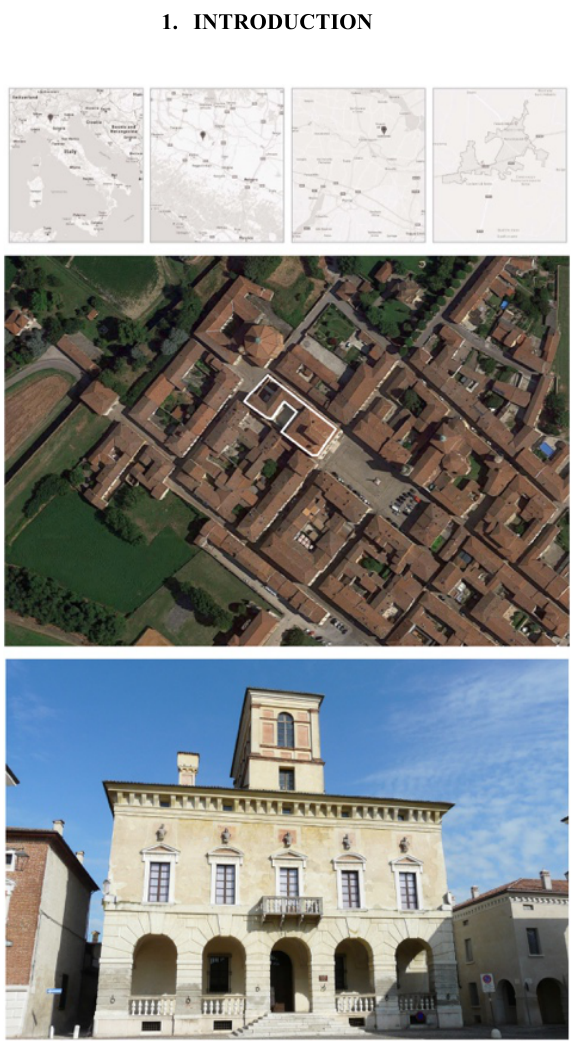
Figure 1. Sabbioneta in Italy, from the google earth, and main façade of Palazzo Ducale